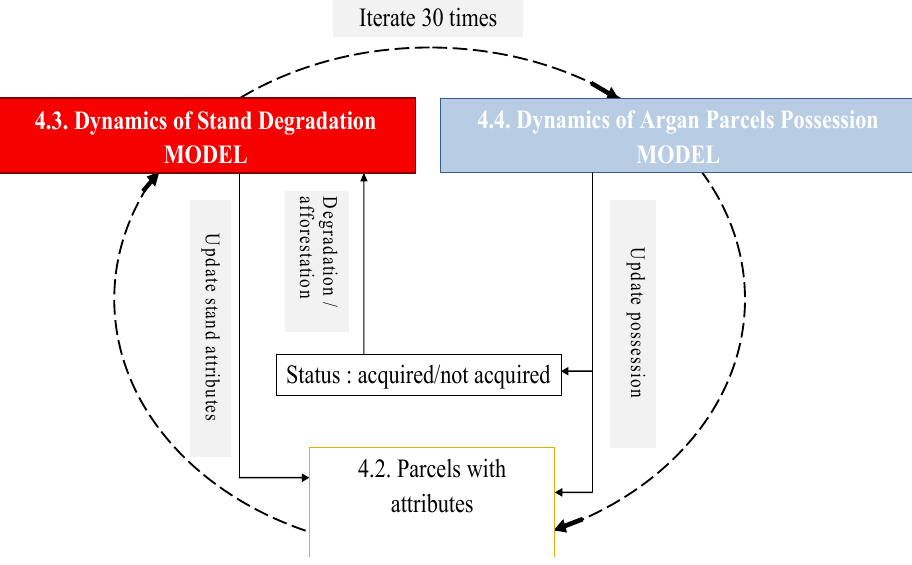
Figure 2. General overview of the core model structure. The modules are described